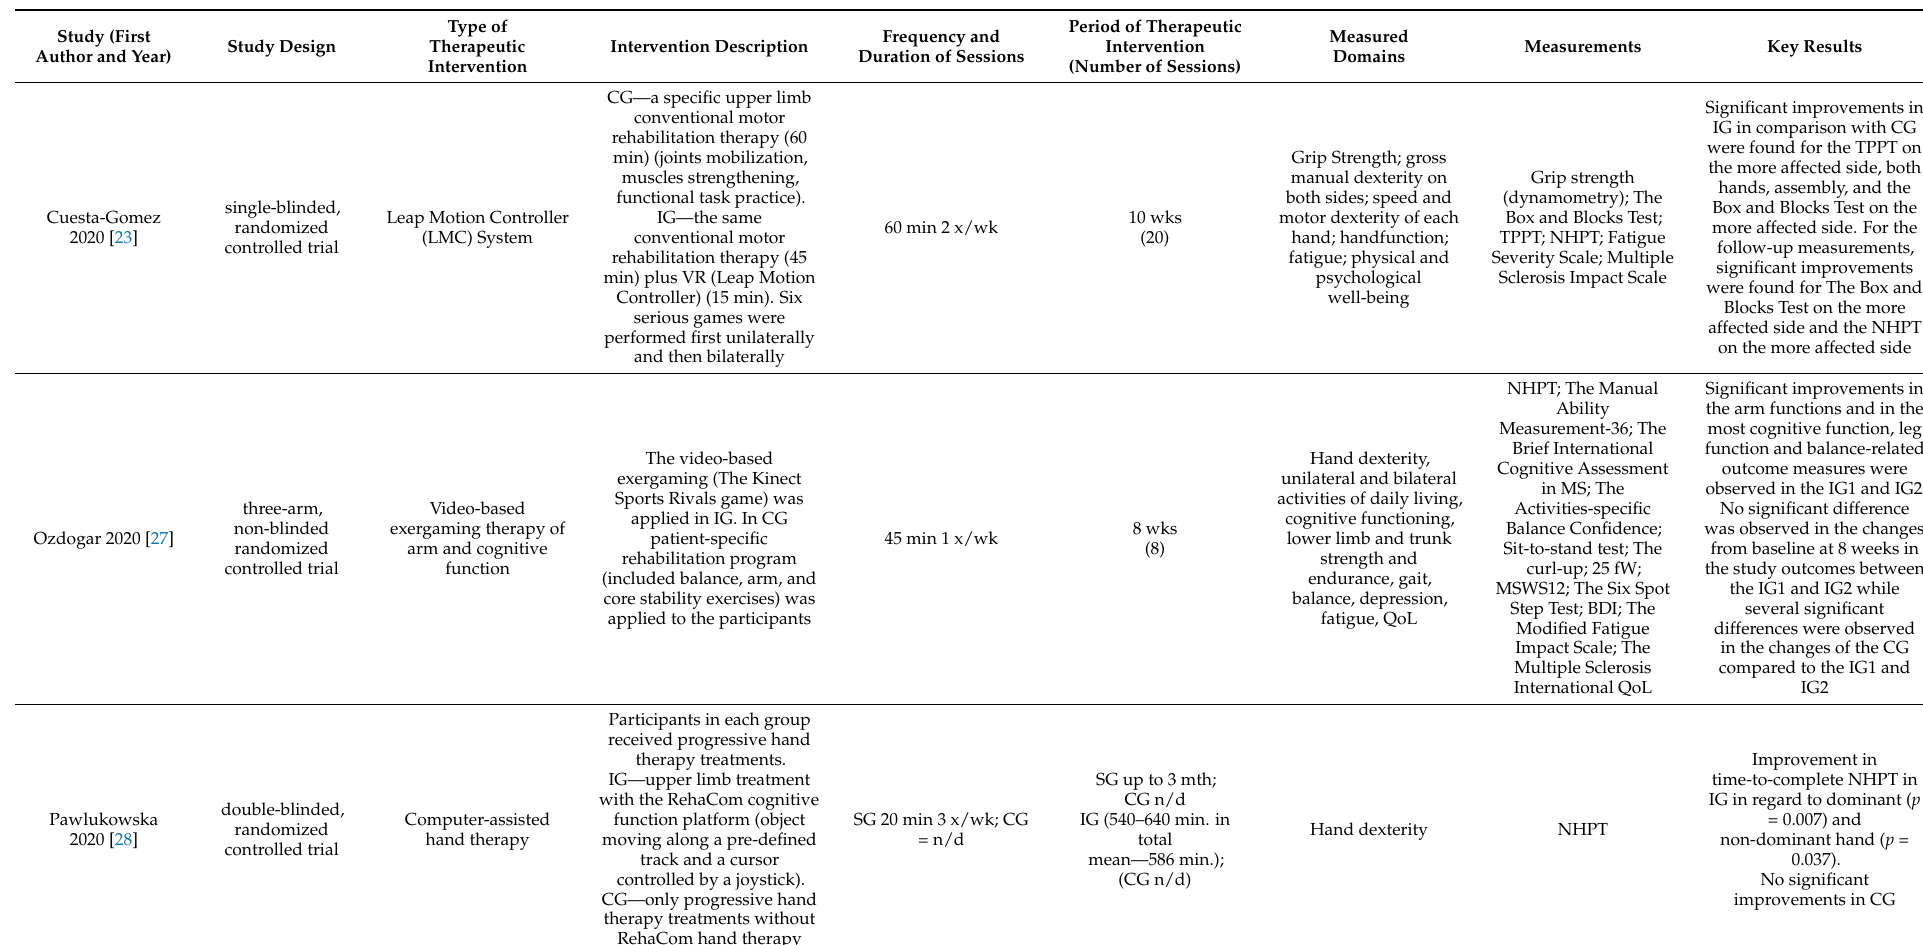
Table 6. Characteristics of studies analyzing the effect of new technologies on hand function in MS